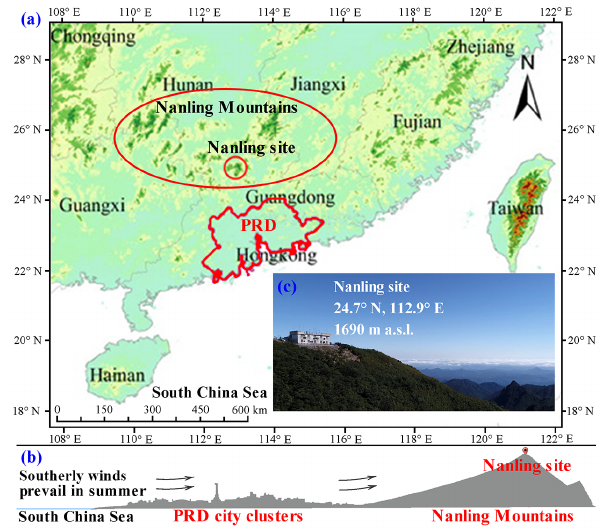
Figure 1. (a) Map showing the location of the Nanling site at the summit of Mt. Tian Jing in southern Nanling Mountains; (b) also shown is the sketch of the cross-section of the PRD and Nanling Mountains; (c) aerial photo of the Nanling site. The base map in (a) and (b) are reproduced from Wu et al. (2016, 2013),